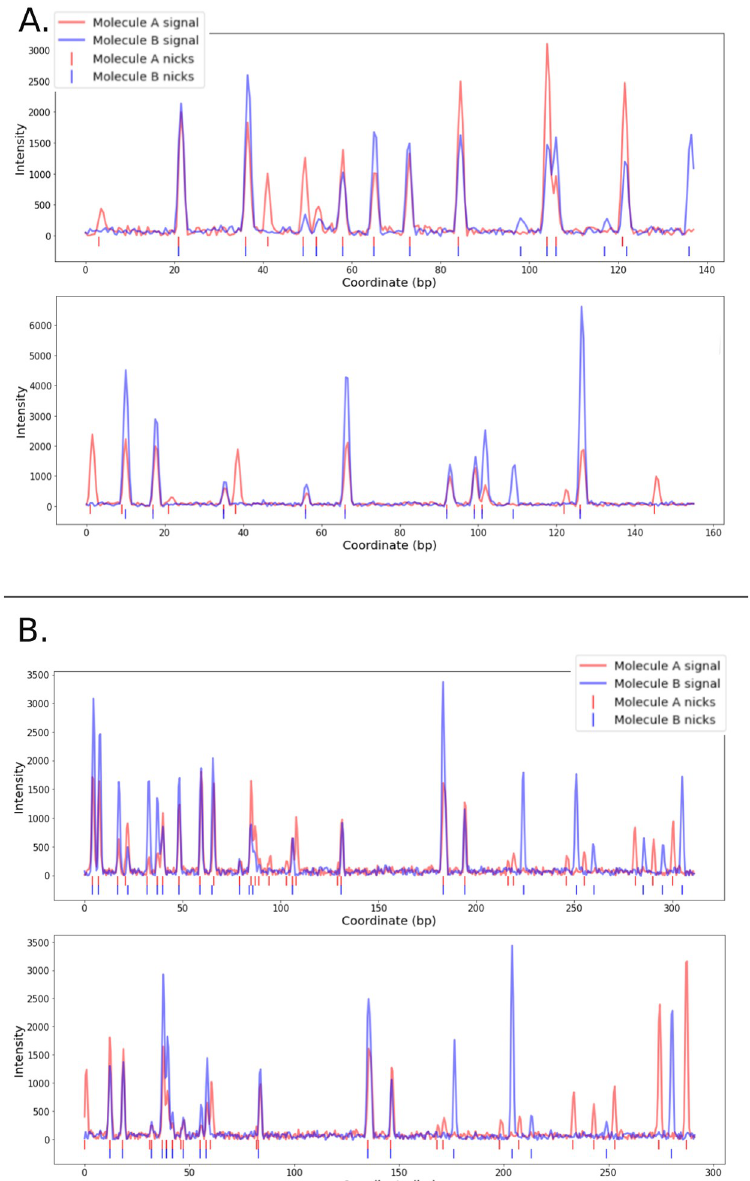
Fig 10. Visualization of overlapping parts of molecule pairs aligned by A. OptiMap and B. RefAligner. All overlaps are shown from OptiMap’s perspective where only global stretching is applied. OptiMap alignment (A.) overlaps tend to be shorter in size, whereas RefAligner alignment overlaps indicate loss of phase due to local stretching after 200bp for the top and 150bp for the bottom alignment. overlapping molecules with a pairwise all-versus-all alignment procedure to create edges in an OLC graph [17]. We assessed the use of OptiMap as an alternative to RefAligner for this align- ment step. However, given to the all-vs-all pairwise normalized cross-correlation step required in OptiMap-naive, the first phase of OptiMap-dense and OptiMap-sparse, OptiMap has quadratic time complexity and does not scale to genome-size datasets for larger genomes. We extrapolated the computation time required for OptiMap-naive and found that it would take over 8,000 hours